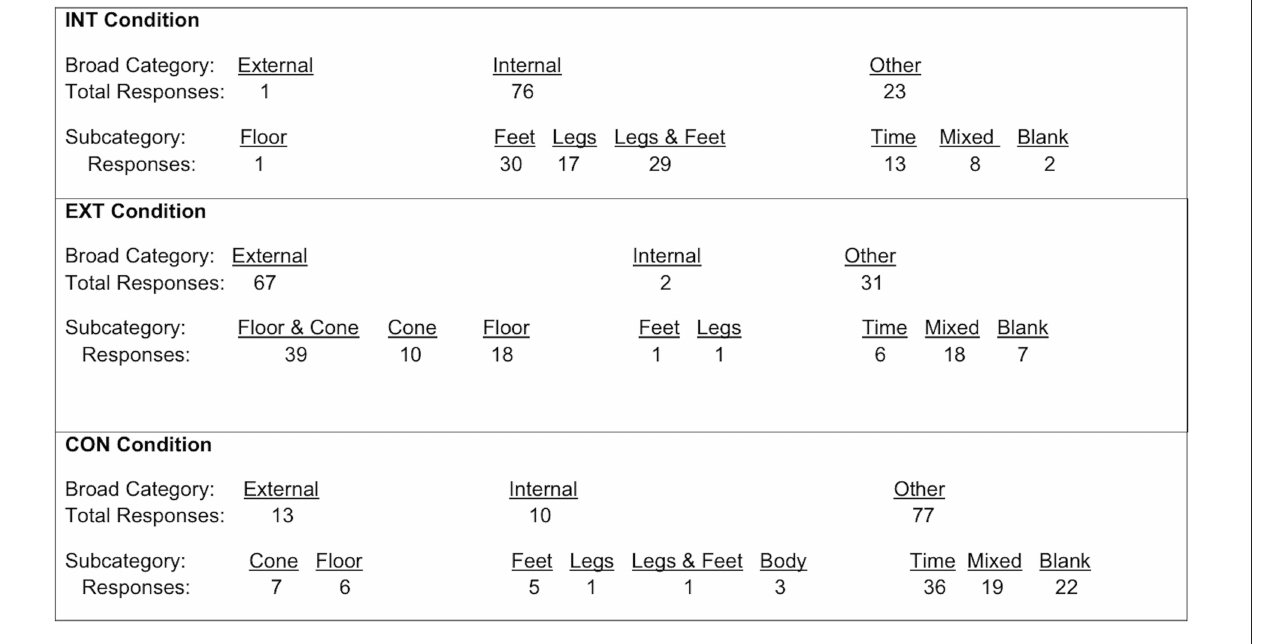
broad category. Within the “Other” category the subcategory of “Time” includes the number responses that suggested the participant focused on cues related to their movement time. The subcategory of “Mixed” includes responses that included a mixture of internal and external